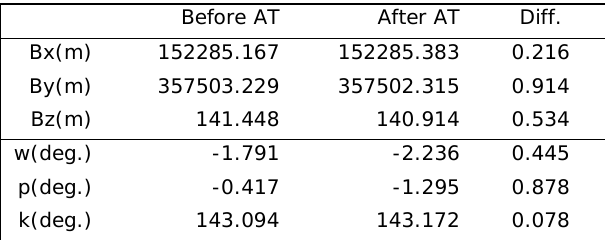
Table 1. EO parameters sample